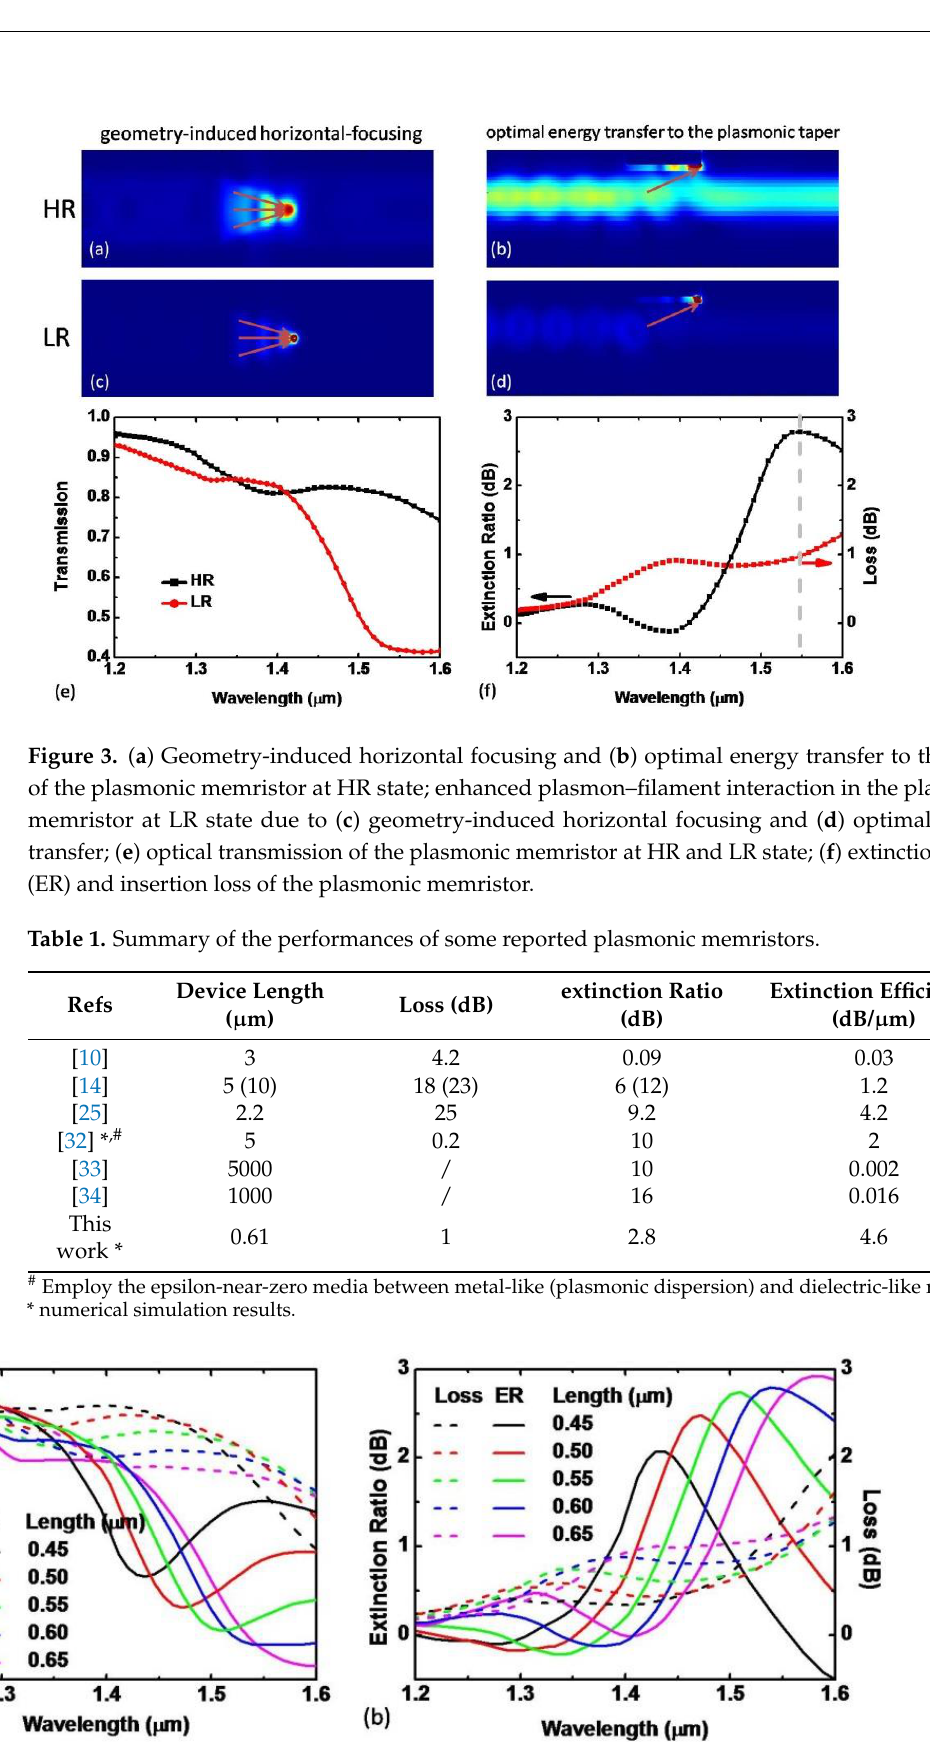
Figure 4. ( a ) Taper length dependence of the optical transmission of the plasmonic memristor at HR and LR states; ( b ) taper length dependence of the extinction ration (ER) and insertion loss of the plasmonic memristor. Table 1. Summary of the performances of some reported plasmonic memristors.